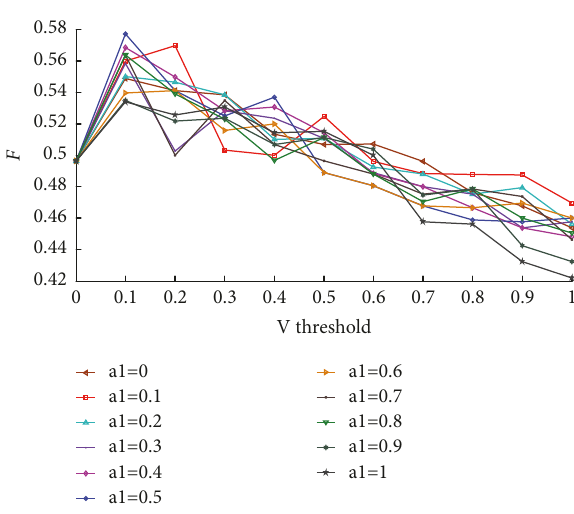
Figure 1: The comparison of the obtained results when a 1 and 𝑉 threshold are given different values.